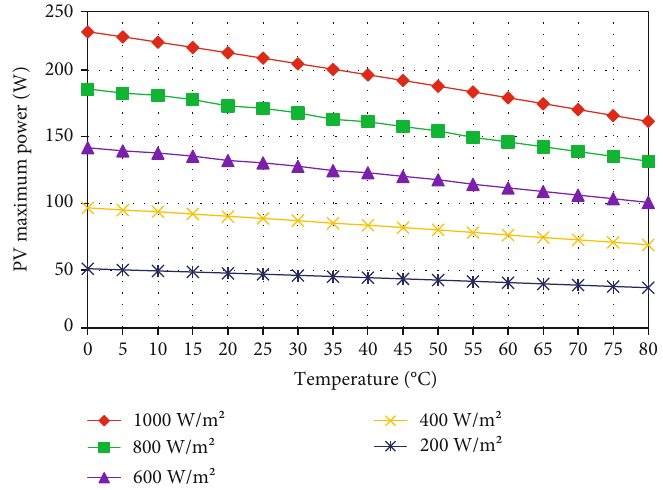
Figure 2: Maximum power variations with temperature changes under di ff erent radiation levels.